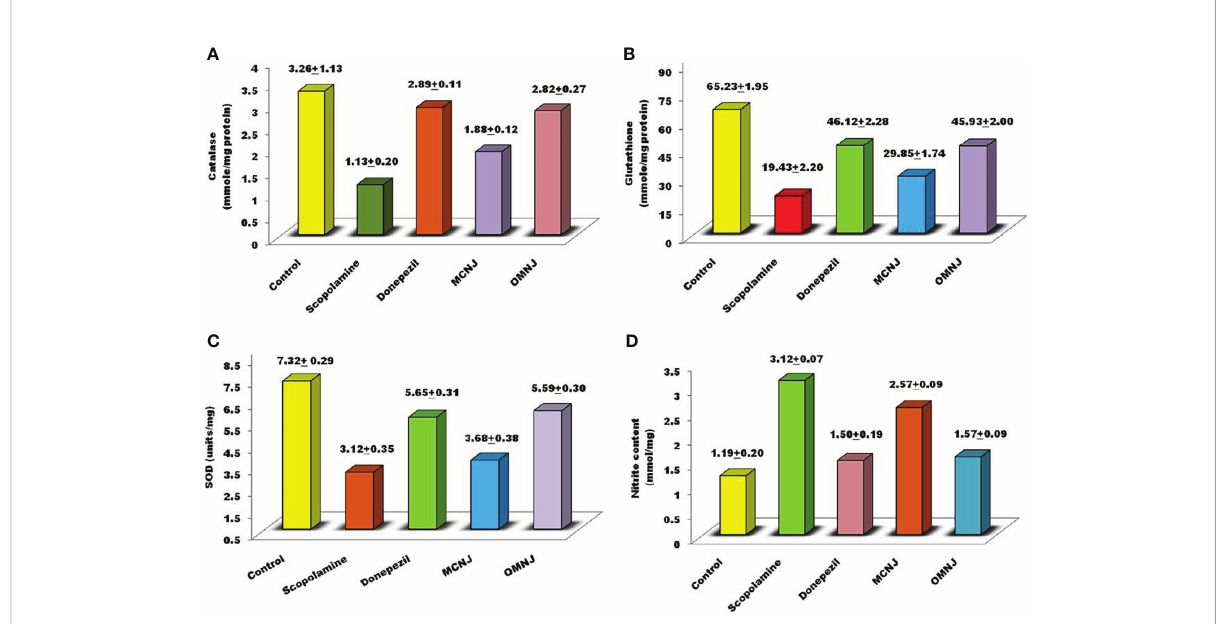
FIGURE 10 Biochemical evaluation of various extracts related to anti-oxidant stress (A) catalase (B) reduced glutathione (C) SOD (D) nitrite